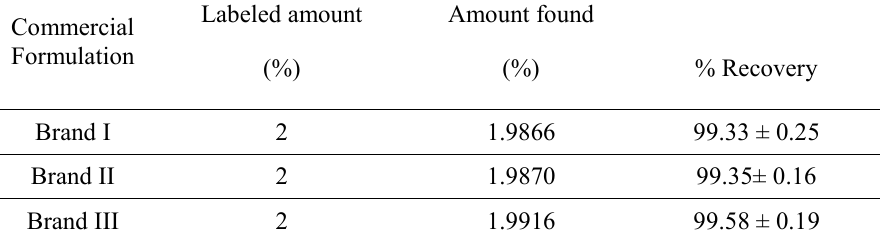
Figure 3. Calibration curve of Dorzolamide by RP- HPLC. Table 2. Analysis of commercial formulations (Eye Drops).